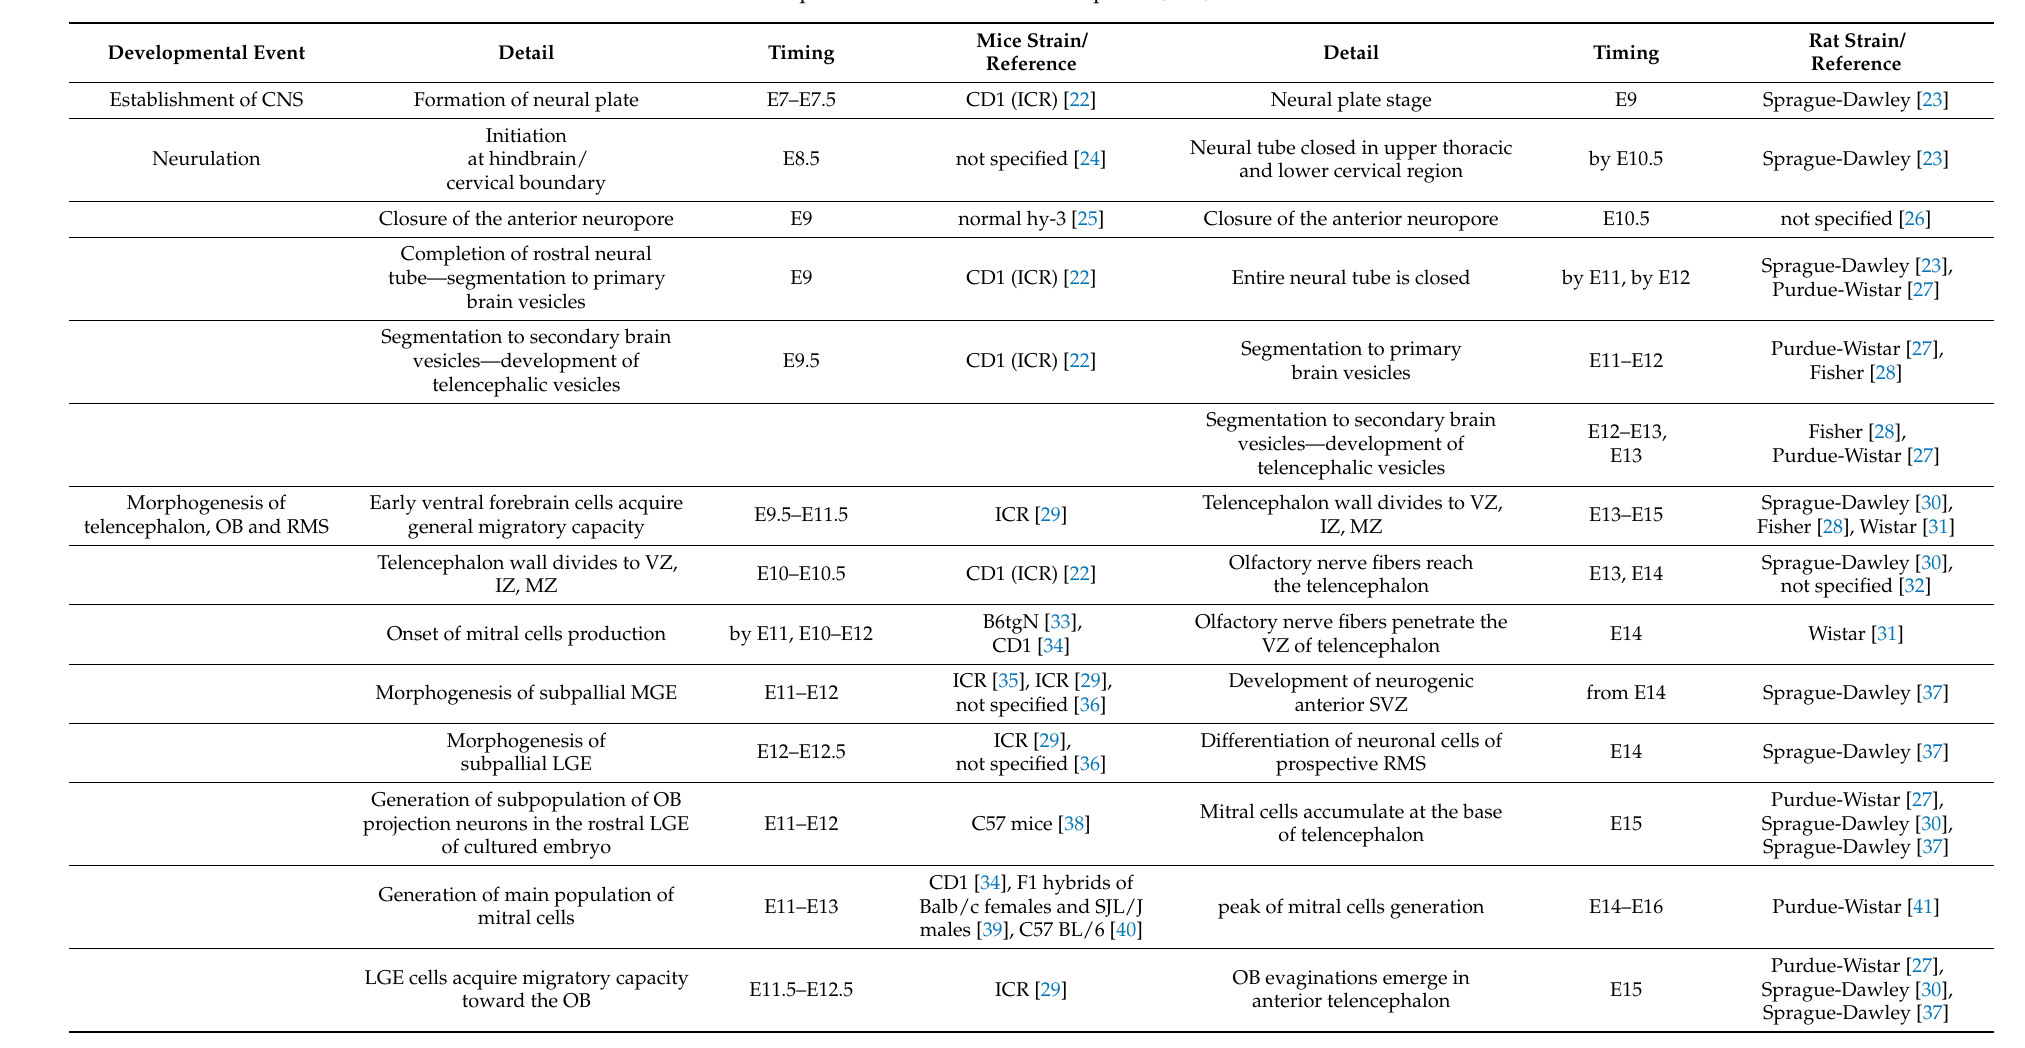
Table 1. Developmental milestones of telencephalon, OB, and RMS